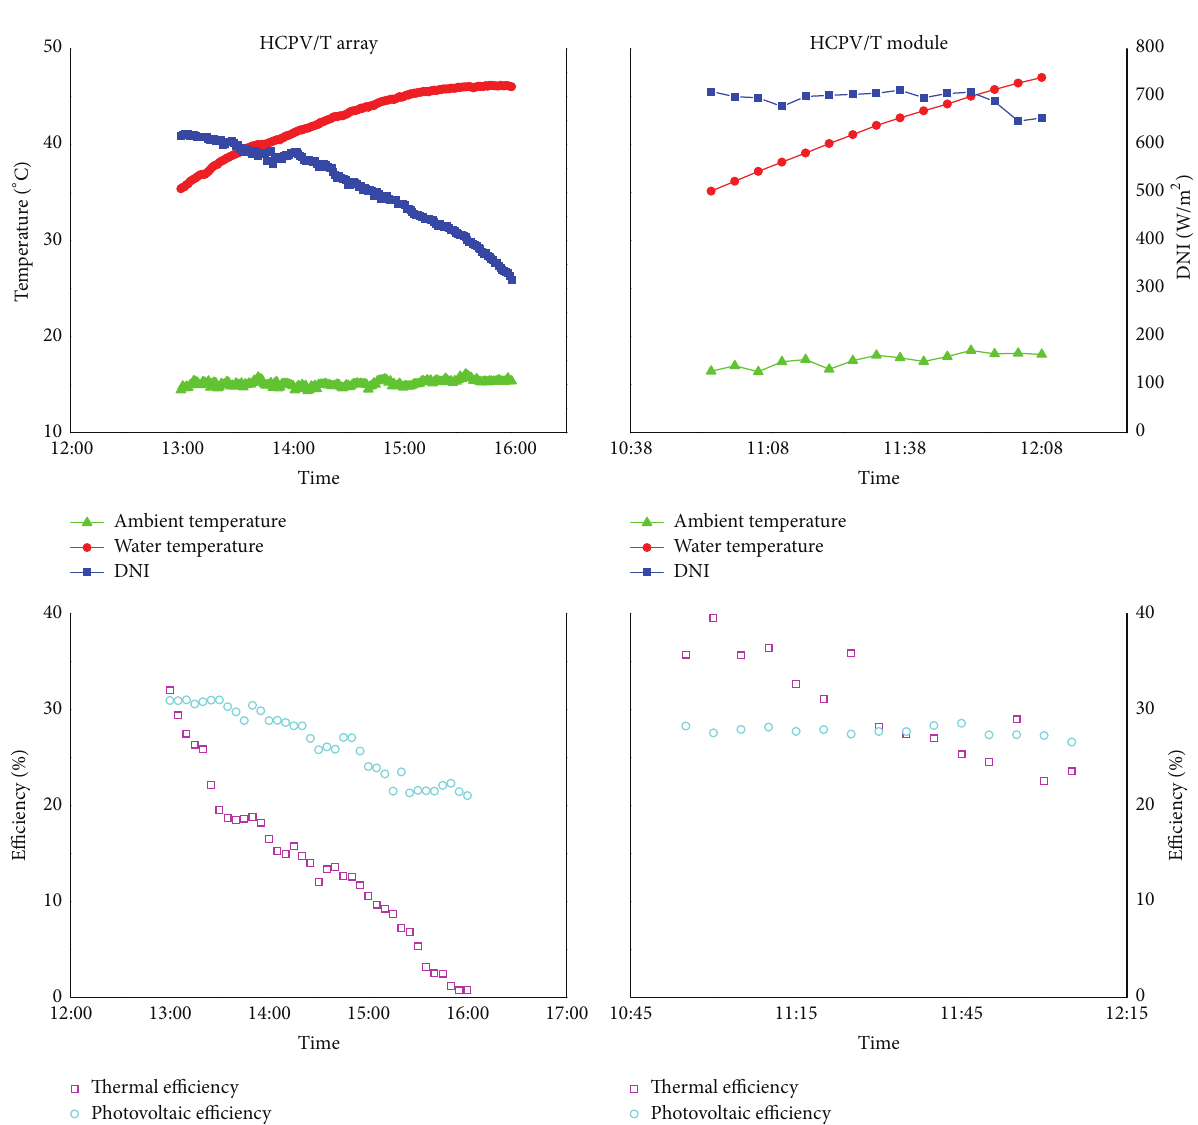
Figure 12: Comparison of performance between the HCPV/T array and a HCPV/T